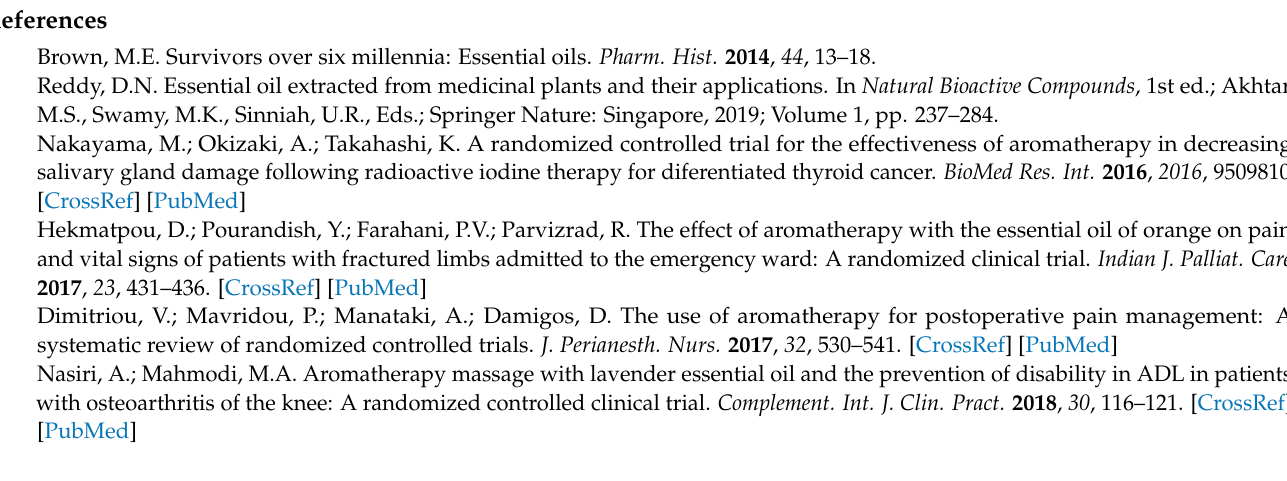
Table S2: Stability over time of fennel essential oil-loaded nanocapsules (FEO-NCs) at 40 ◦ C. Table S3: Fennel essential oil composition over time of FEO-loaded nanocapsules at 4 ◦ C. Table S4: Fennel essential oil composition over time of FEO-loaded nanocapsules at 40 ◦